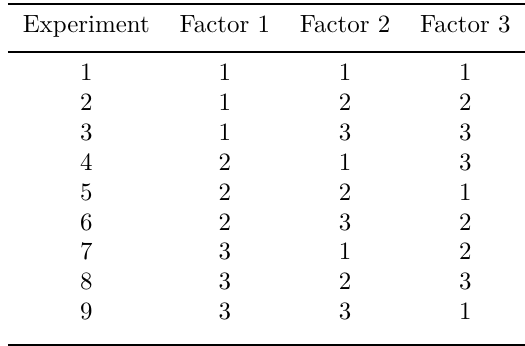
Table 2. Taguchi orthogonal array L